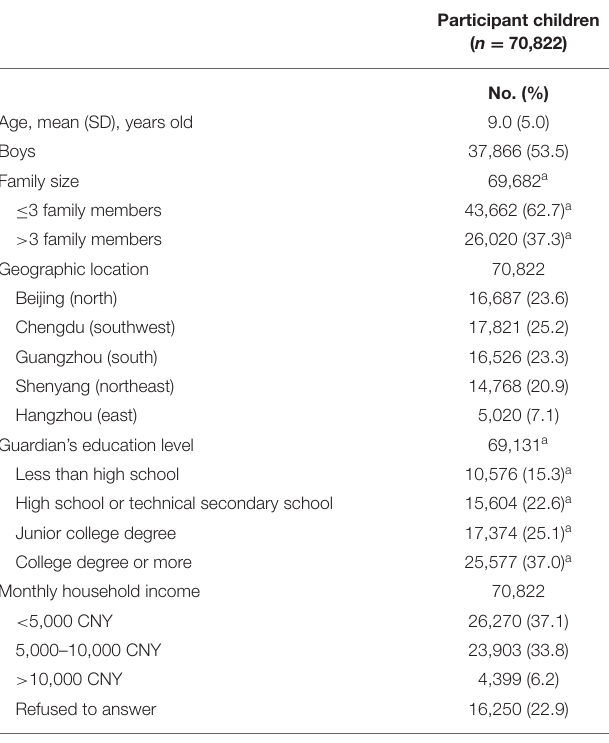
TABLE 1 | Characteristics of demographics and socioeconomic status of children